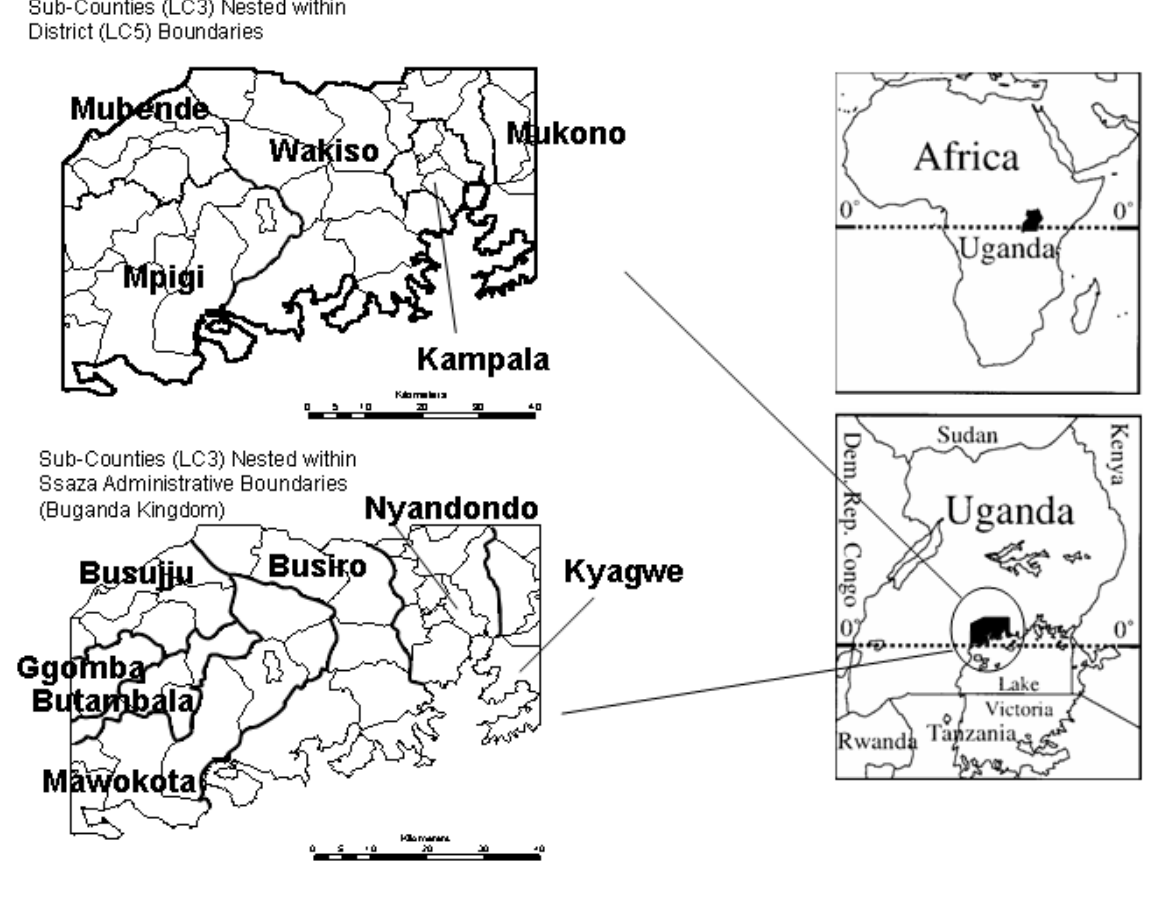
Fig. 1. Maps of the study area, including those showing the subcounty, gombolola, units nested within both district and traditional county, ssaza units, which have importance in this study. Graphics were constructed by Nathan